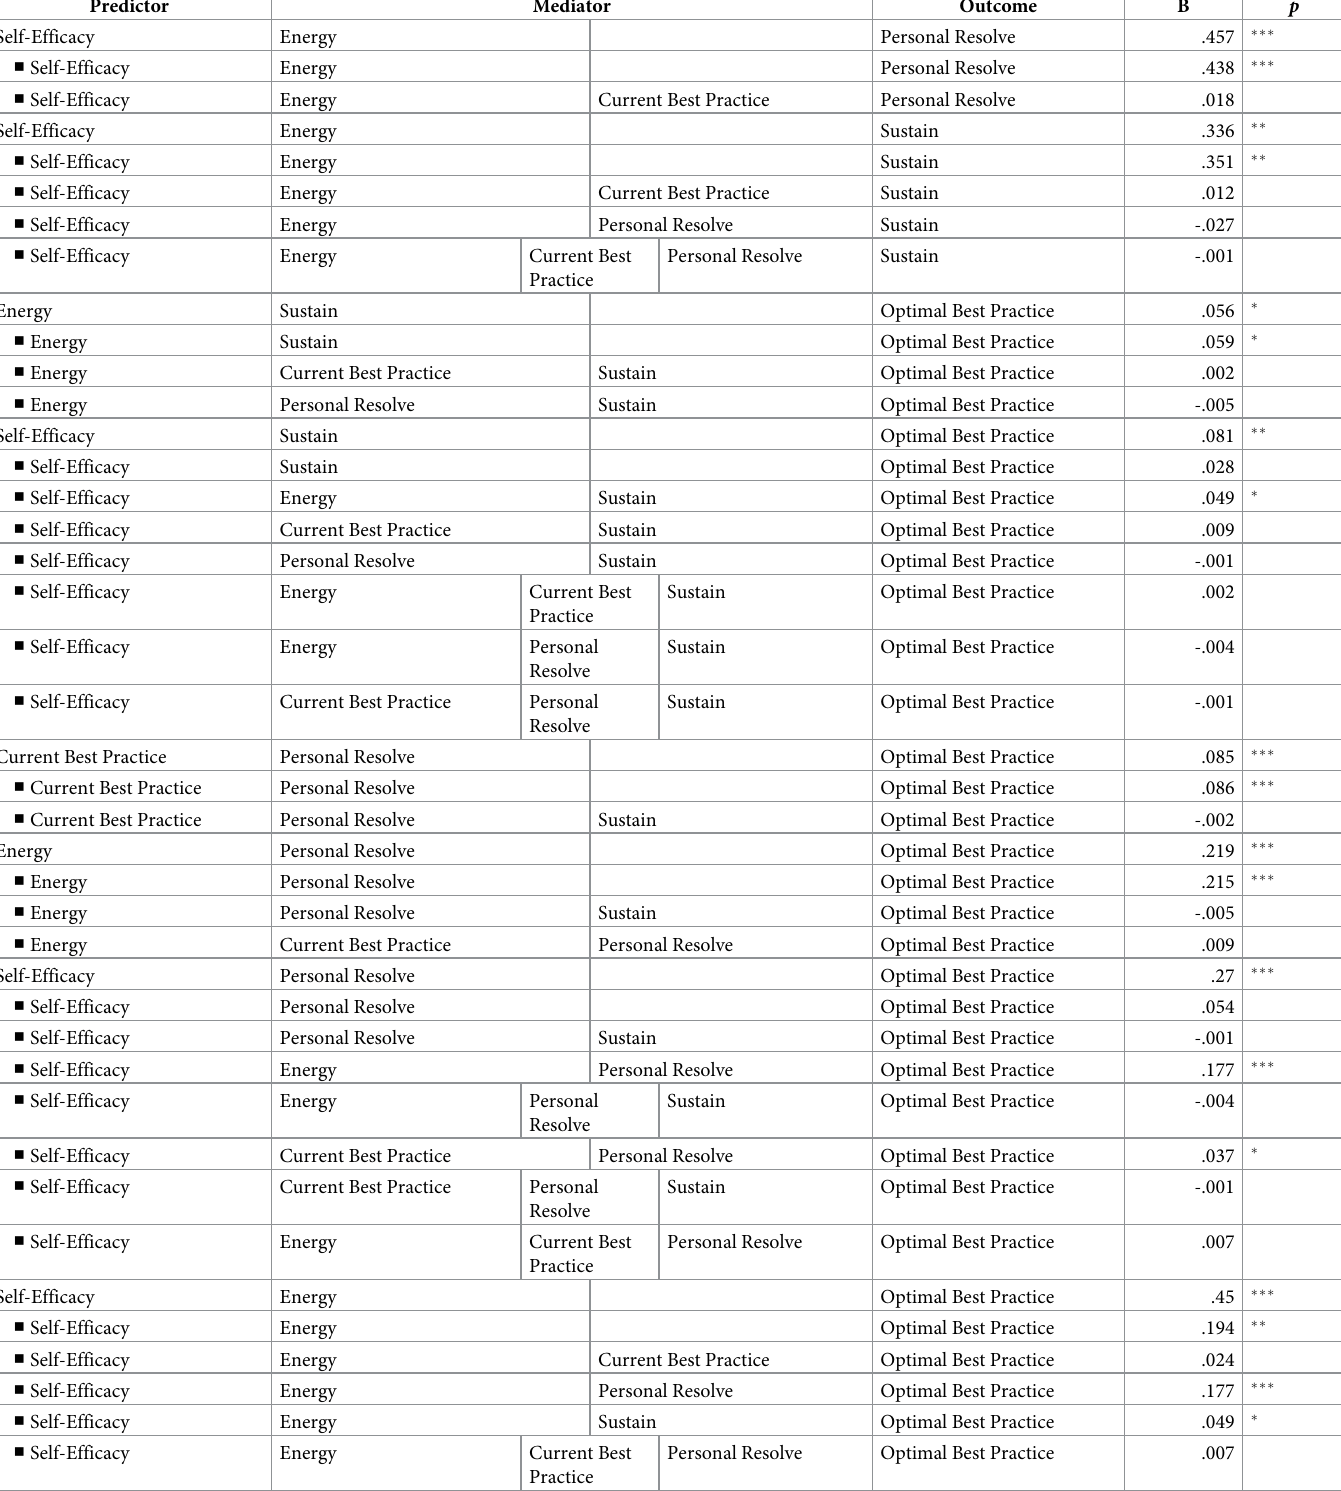
Table 3. Decomposition of indirect effects and potential mediating